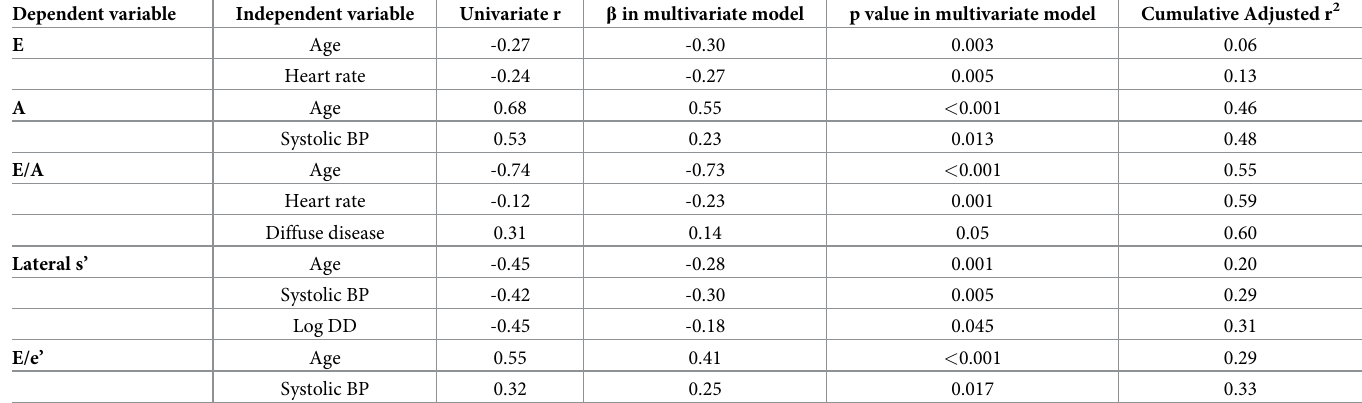
Table 5. Selected Multivariate models of selected LV filling and LV long-axis TDI variables. Dependent